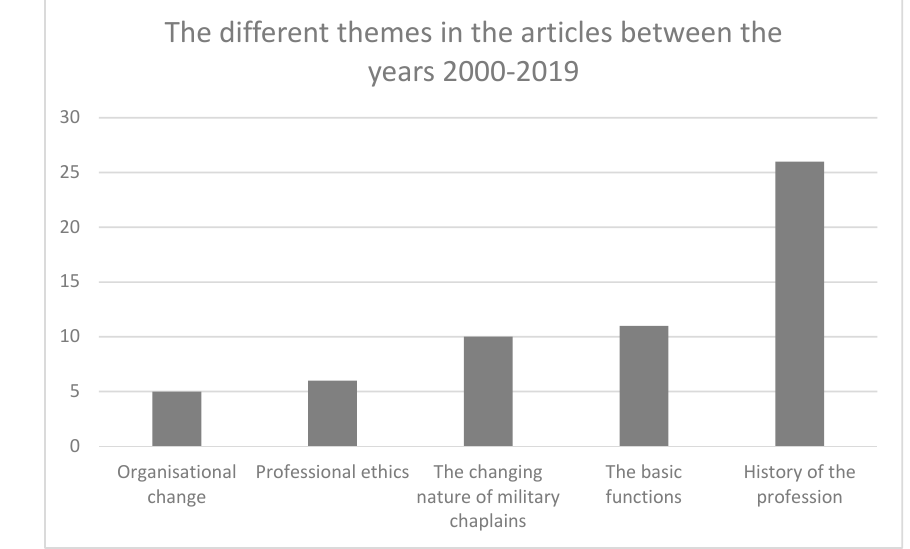
Figure 1. The different themes in the articles. Figure 1. The di ff erent themes in the